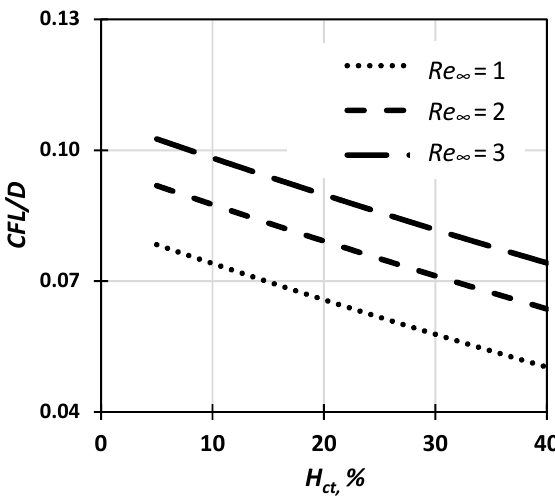
Figure 11. Comparison of the current correlation (Equation (6)) with CFL experimental data of this